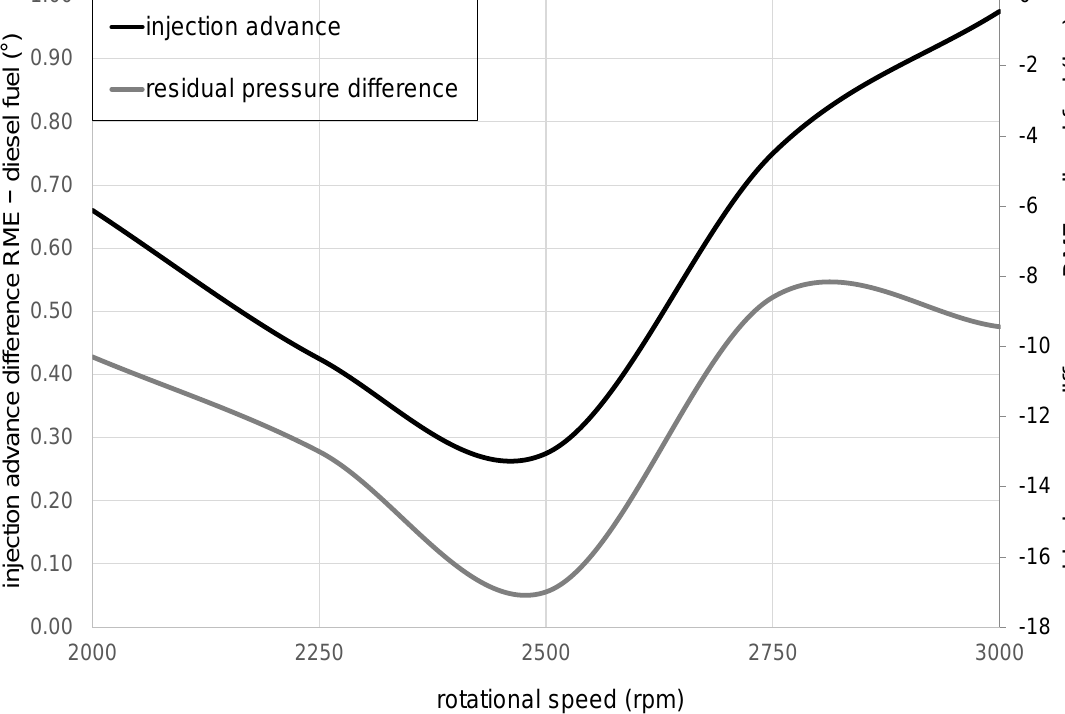
Figure 13. Injection advances with the RME and the diesel fuel and residual pressure difference between the same two fuels as a function of the engine speed and at full load.